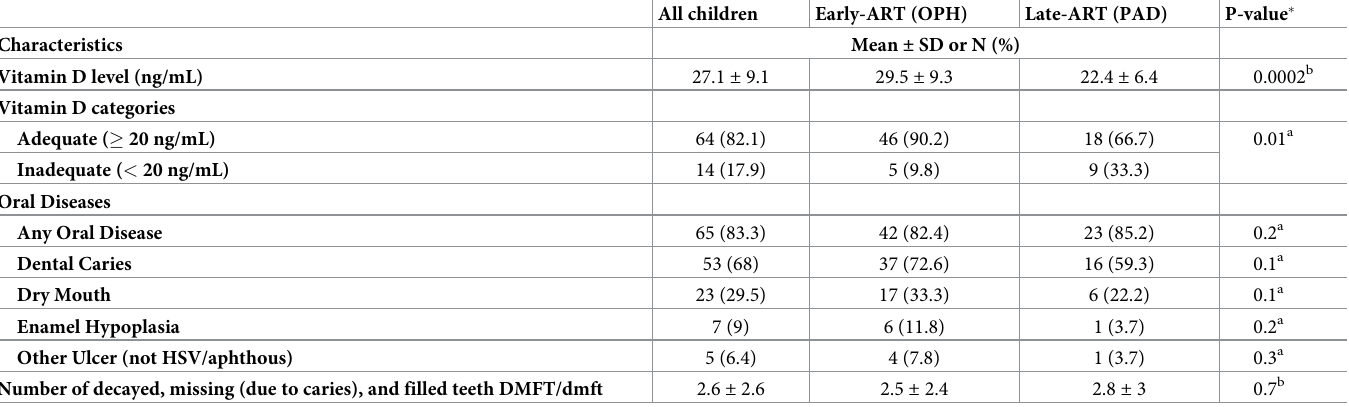
Table 2. Levels of vitamin D and oral diseases by ART initiation